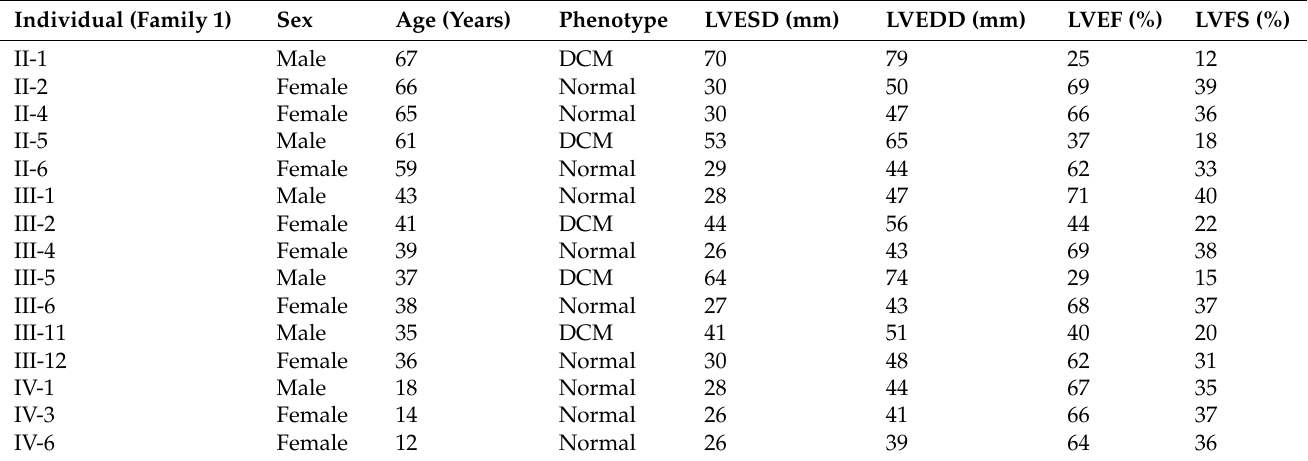
Table 1. Baseline clinical characteristic information of the living pedigree members available from Family 1.